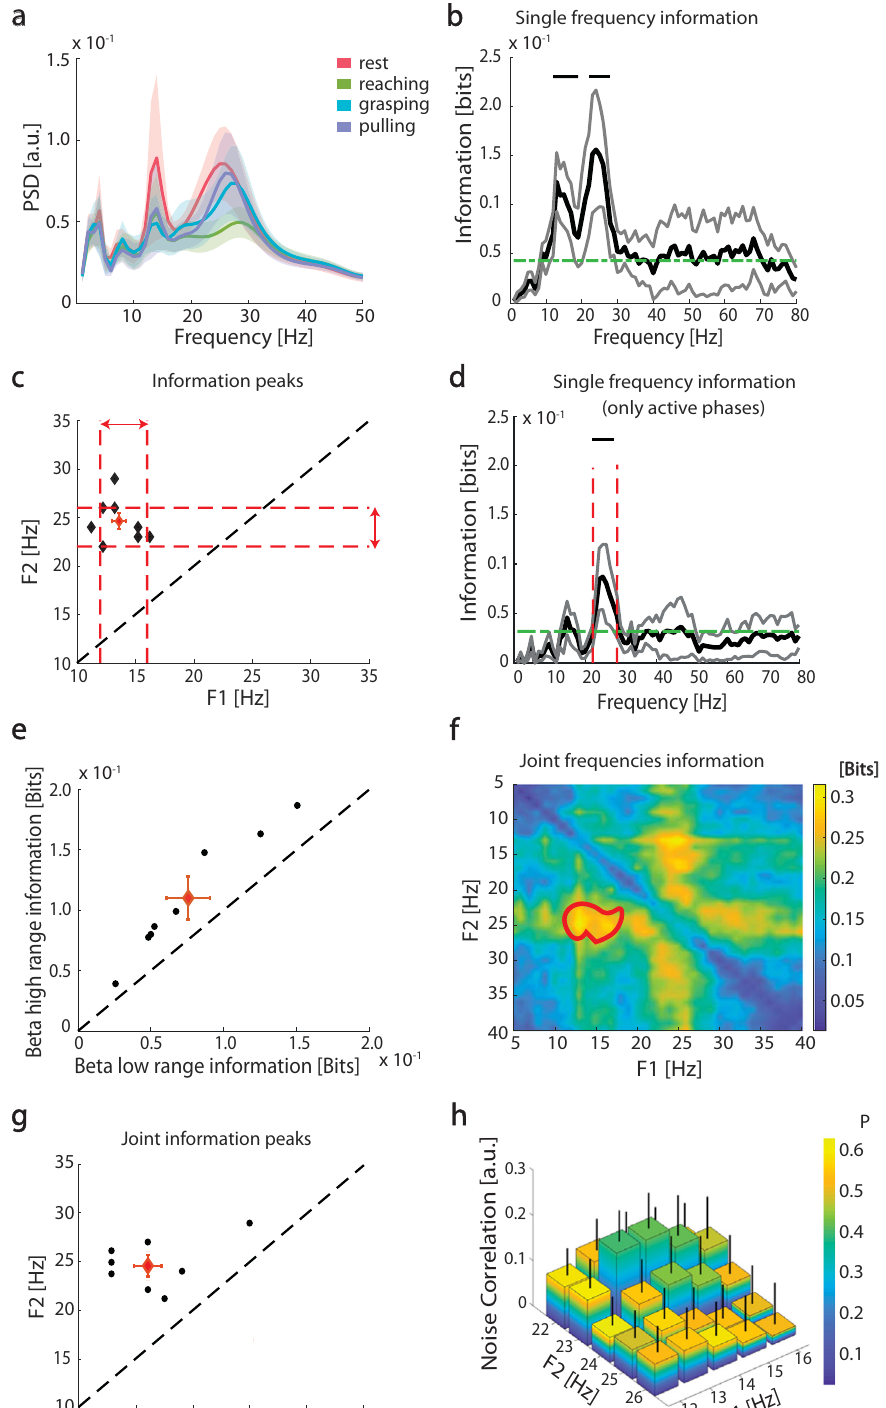
In a second set of analyses, we computed the information only for the active phases (reaching, grasping, and pulling), excluding rest (see “ Methods ” section). Signi fi cant information about active phases was carried by the beta high range, but not the beta low range (Fig. 2d). The information carried by the beta high range linearly correlated across subjects with the power change (as percentage vs. rest, see “ Methods ” section) ( R 2 = 0.82, p =